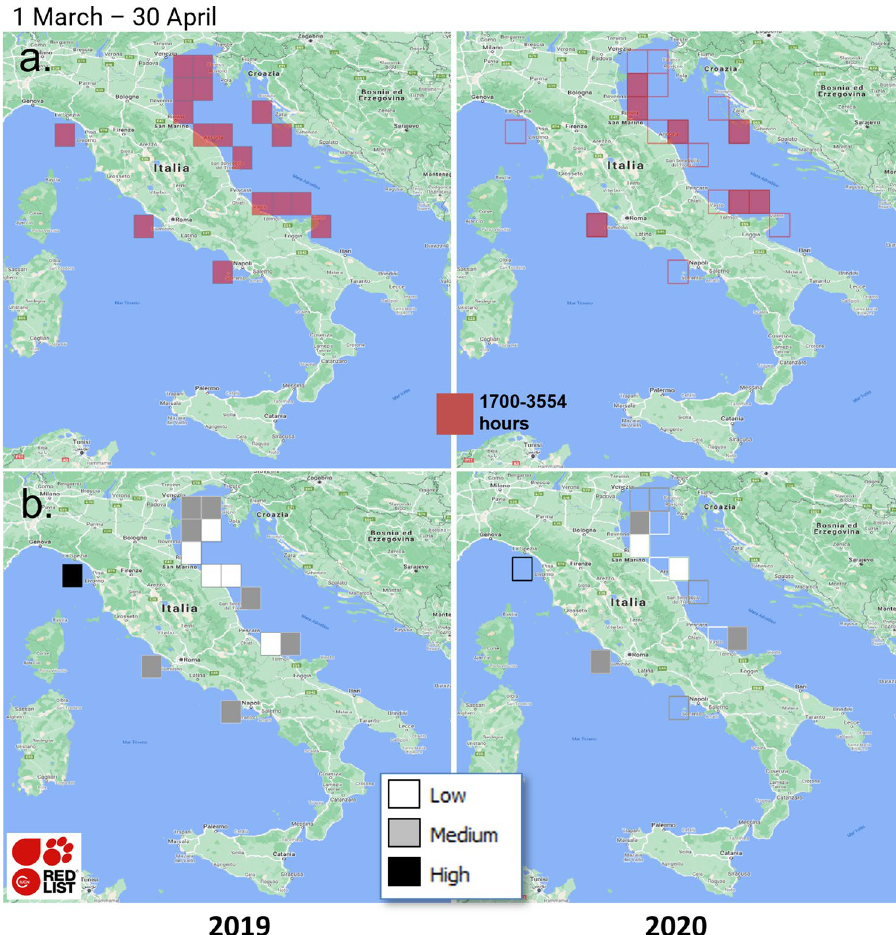
◦ Figure 1. ( a ) Log-normal selection of 0.5 high-effort fishing locations, in the Italian seas, from Global Fishing Watch data from 1 March to 30 April. ( b ) Number (high, medium, low) of endangered, threatened and protected (ETP) species recorded at these locations. To enhance the comparison, the outlines of the 2019 cells (left) are reported in the 2020 maps (right). Maps were created with QGIS v.3.20.2 (www. qgis. org) using Google Maps-Satellite as the background map (version of 8 November 2021) (https:// maps. google.